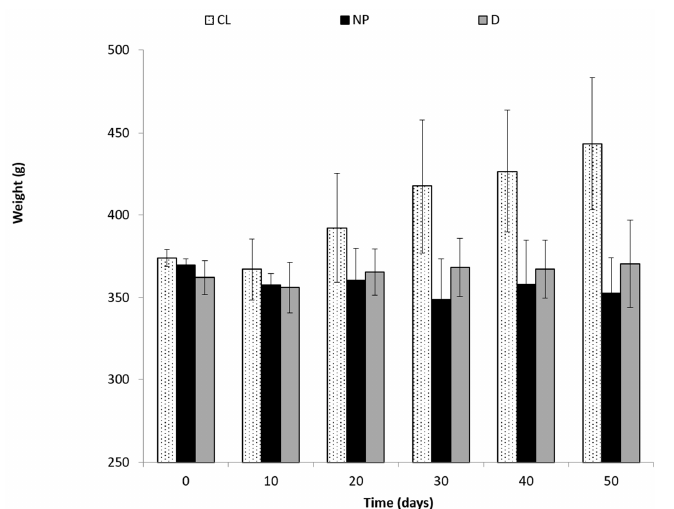
Figure 1. Growth performance of juvenile dusky grouper ( Epinephelus marginatus ) submitted to dif- ferent photoperiods for 50 days. Continuous light (CL = 24 h light), normal photoperiod (NP = 10/14 light/dark) and continuous darkness (D = 24 h dark). Values indicated are means (SE) of four